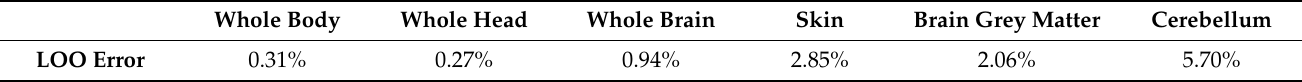
Table 1. LOO-Error values of the surrogate models for tissue average SAR in the whole body, whole head, and whole brain and for SAR 10 g in skin, brain grey matter, and cerebellum. Whole Body Whole Head Whole Brain Skin Brain Grey Matter Cerebellum LOO